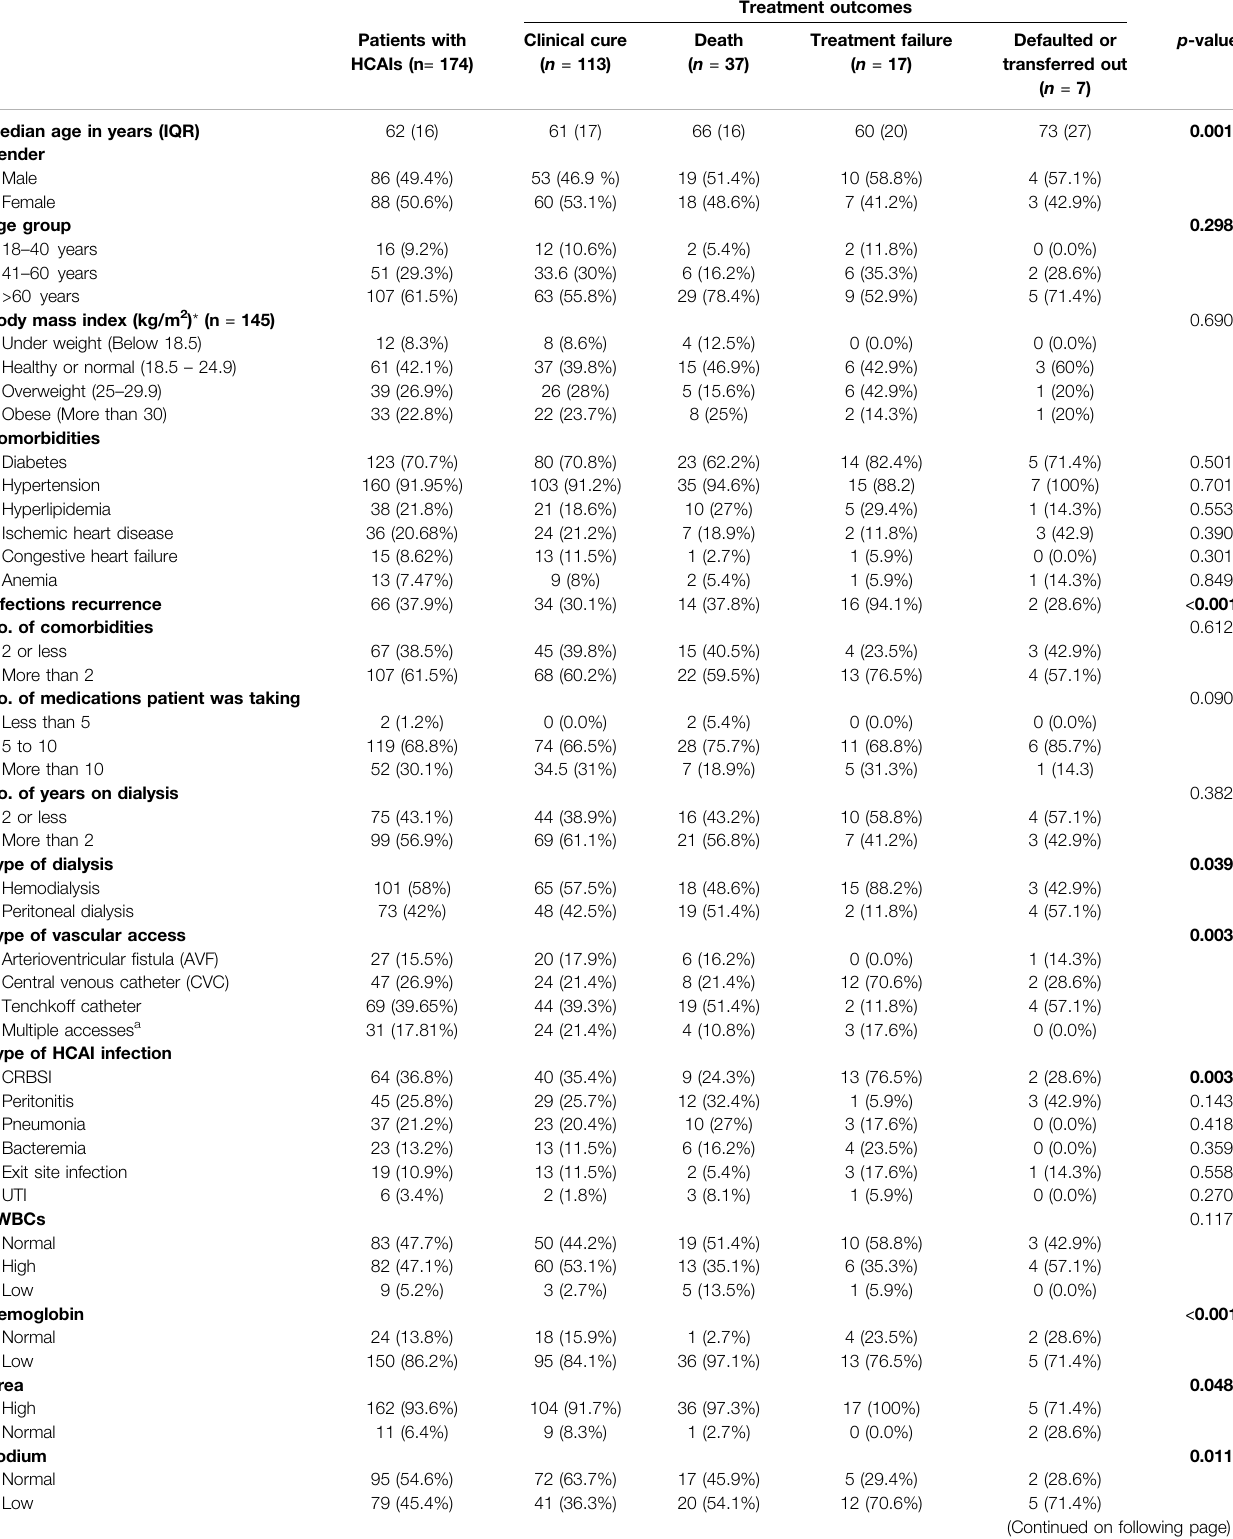
TABLE 4 | Demographics and clinical variables associated with treatment outcomes of healthcare associated